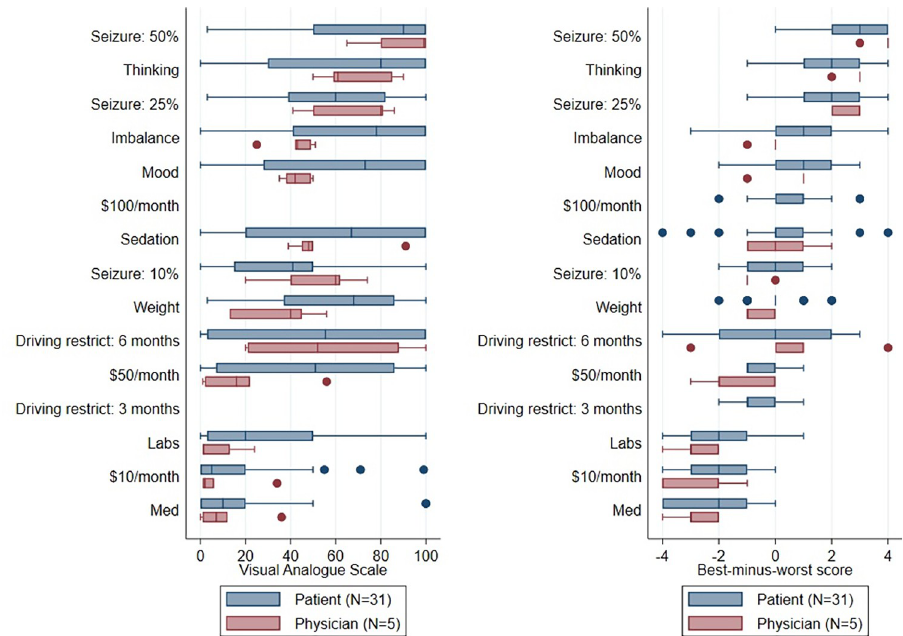
Fig 1. Preference distributions. Left: Visual Analogue Scale. Right: Best-minus-worst scores. Note the 3-month driving restriction and $100/month items were only asked for the patient best-worst scaling questions, in response to physician feedback.